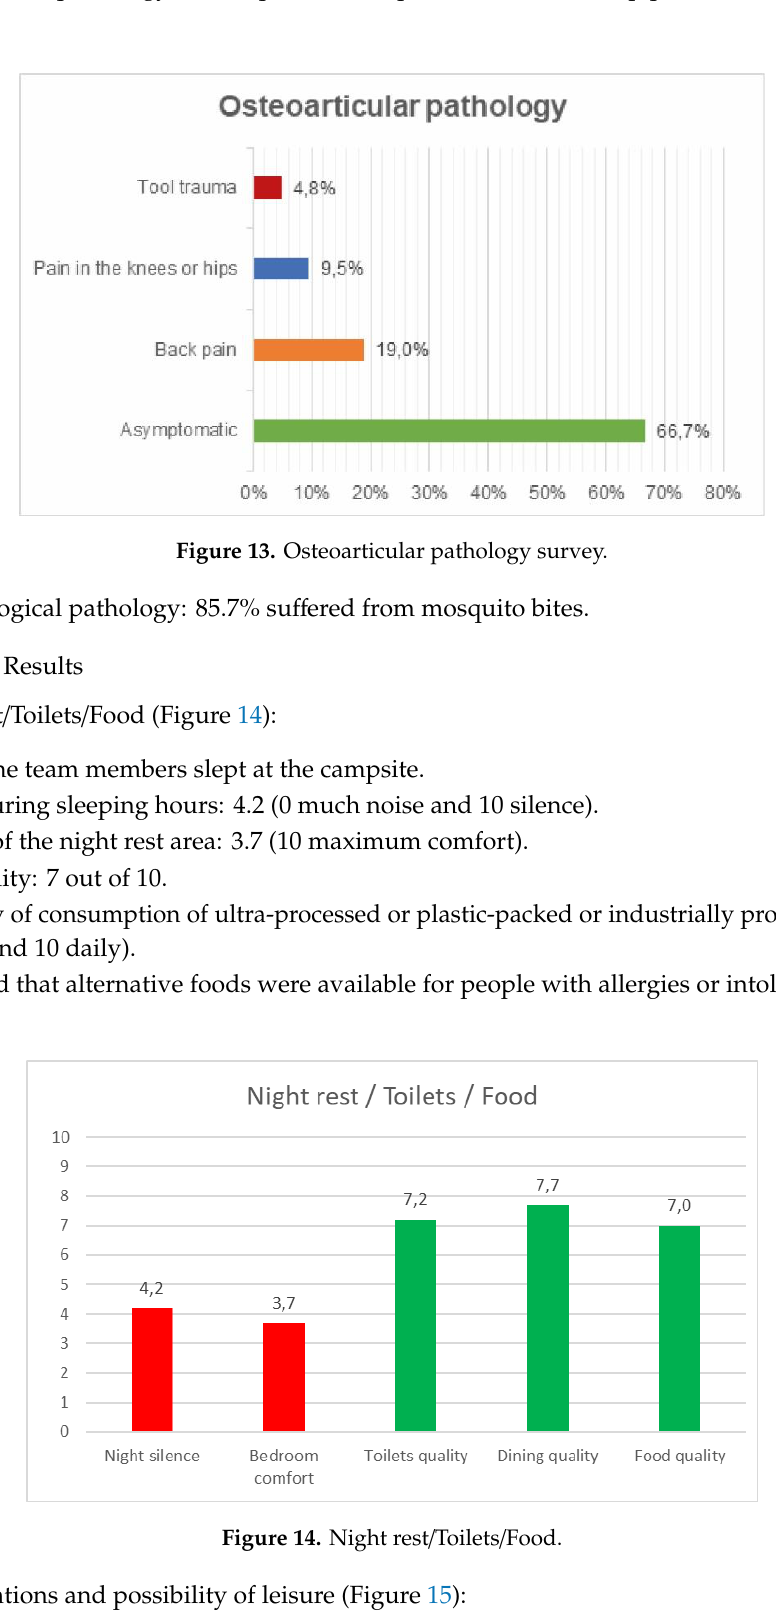
Figure 12. Neurological pathology survey.